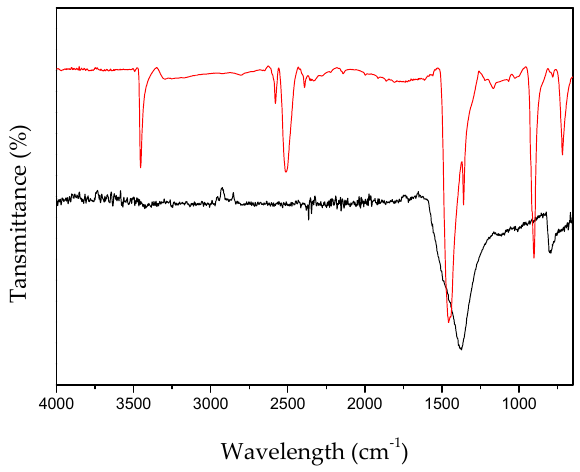
Figure 3. FTIR spectra recorded on pure PBN ( red ) and TiBN1200 ( black ).